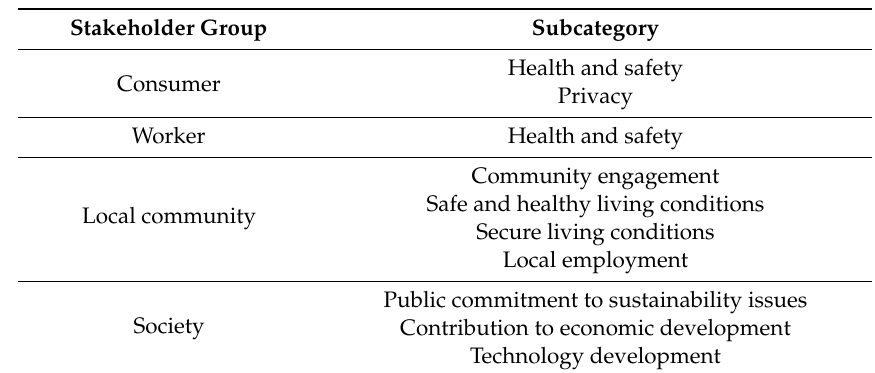
Table 2. Subcategories targeting the individual in